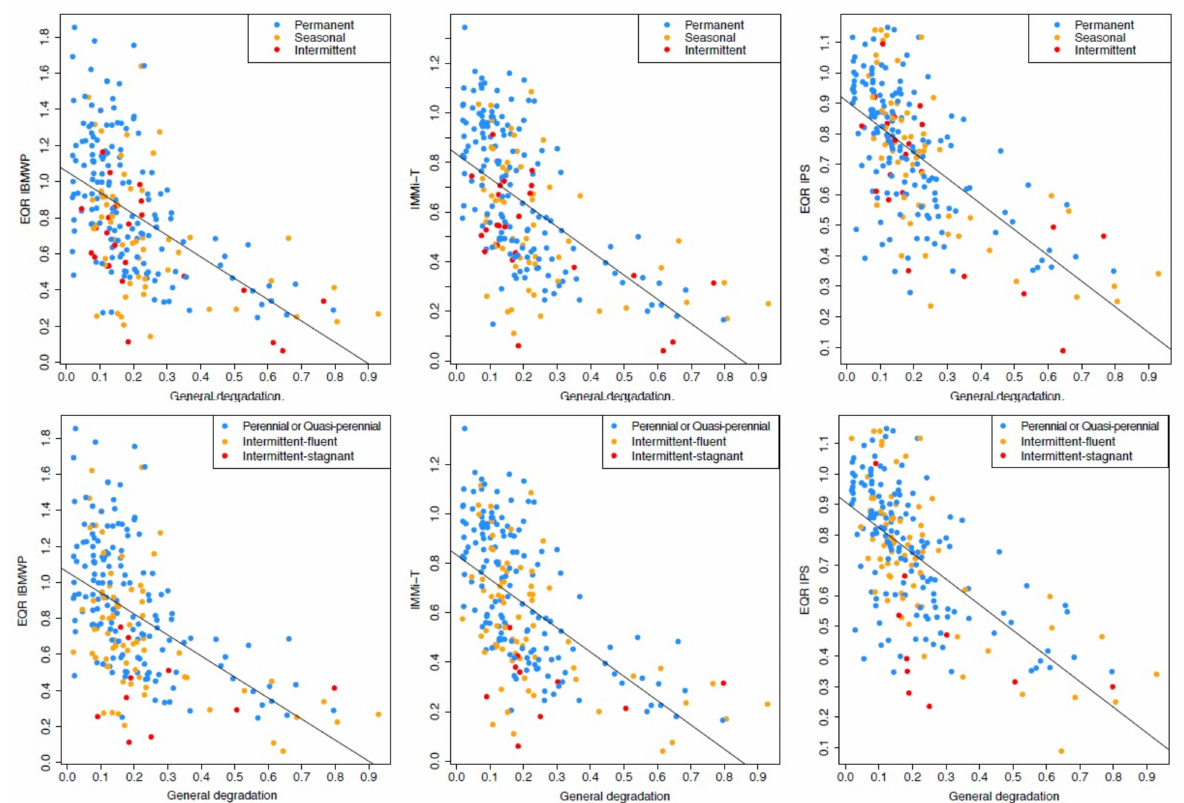
Figure 3. Biological quality indices (IBMWP, IMMI-T, and IPS) compared with a “general degradation” gradient. Two TR river classifications are showed: (i) “natural flows prescribed regimes” (NFPRs) established by using a rainfall-runoff model (above); and (ii) “management temporary river categories” (MTRCs) provided from the TREHS software